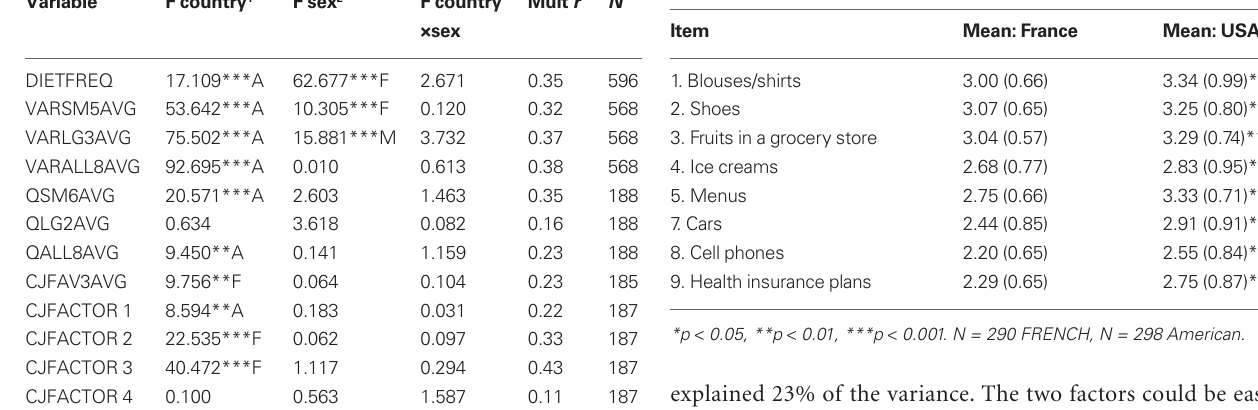
Table 3 | Sex × country ANOVA on combined variables. Table 4 | French and American scores on all items bearing on variety [mean